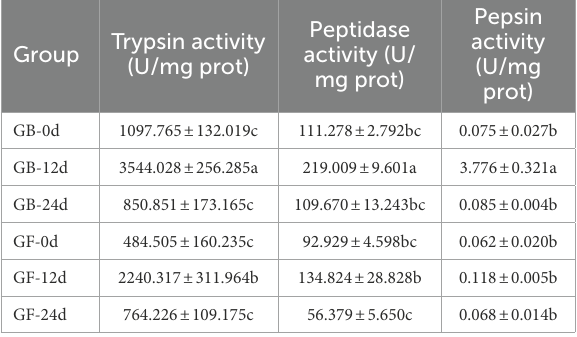
TABLE 4 Gut proteolytic enzyme activity during BSFL conversion to artificial diets.